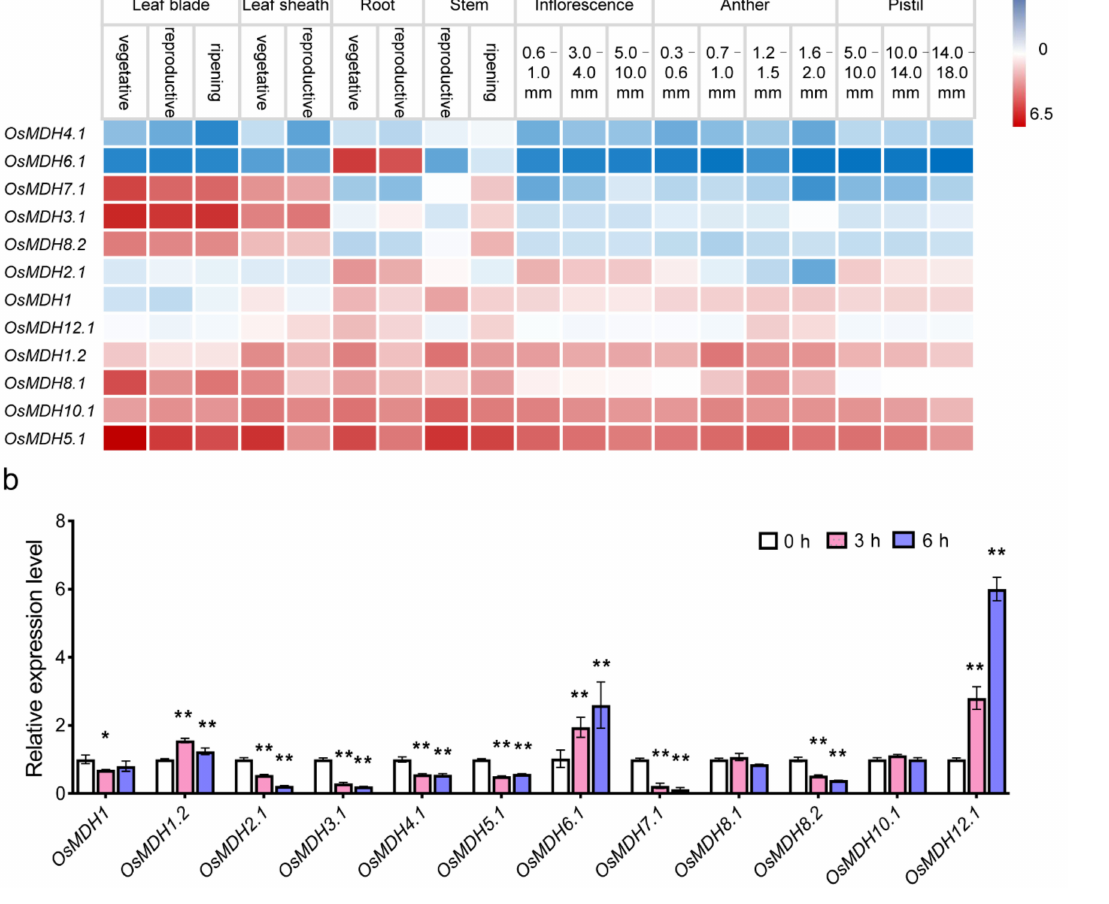
Figure 4. Expression patterns of OsMDH gene family in rice. ( a ) The expression profiles of different tissues and development stages of OsMDH genes in rice without salt treatment. ( b ) Expression analysis of 12 OsMDH genes under salt stress by qRT-PCR. * and ** indicate a significant difference between the treatment and control at the 0.05 and 0.01 probability levels,